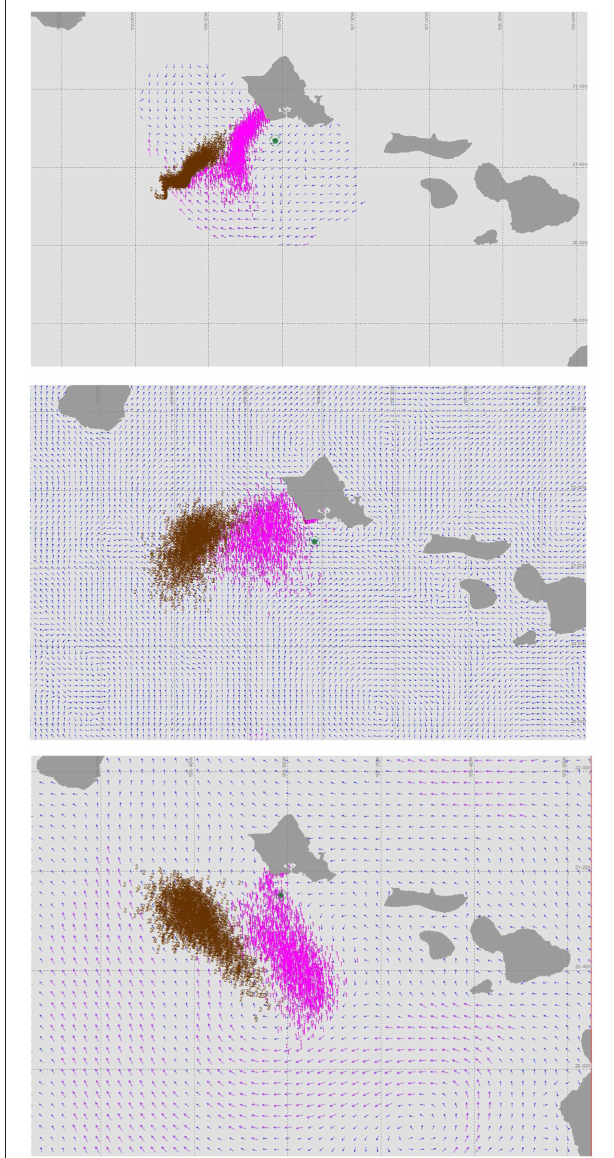
FIGURE 3 | SAROPS output from a simulated SAR case off Oahu. top : Particle density map for a 14 foot sit on top kayak (brown) and person in the water (pink) using ocean current data from available HF Radars. middle : Particle density map for a 14-foot sit on top kayak (brown) and person in the water (pink) using ocean current data from available HROM. bottom : Particle density map for a 14-foot sit on top kayak (brown) and person in the water (pink) using ocean current data from available global